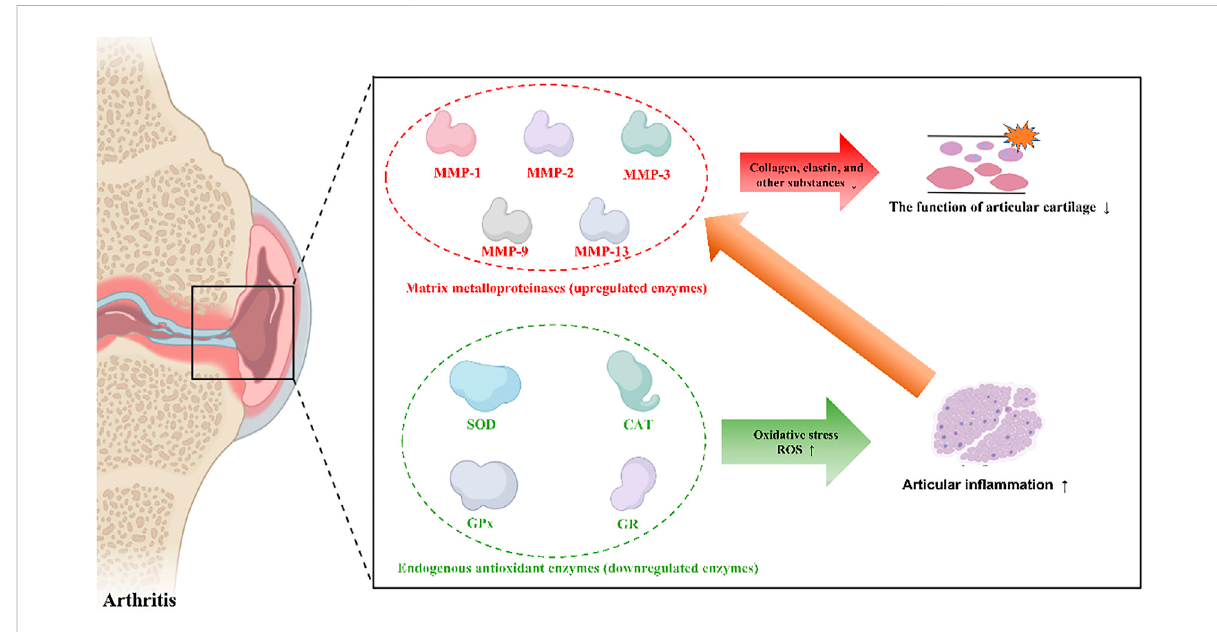
FIGURE 1 Upregulated enzymes (red) and downregulated enzymes (green) in arthritis